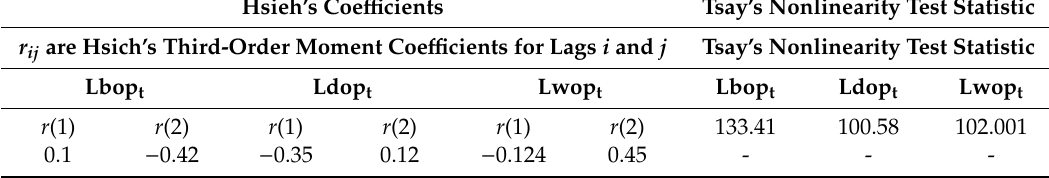
(cid:104)(cid:80) (cid:105) (cid:104)(cid:80) (cid:105) 1.5 x t x t − i x t − j / T x 2 / / T . Only coefficients for r (1, 1) t